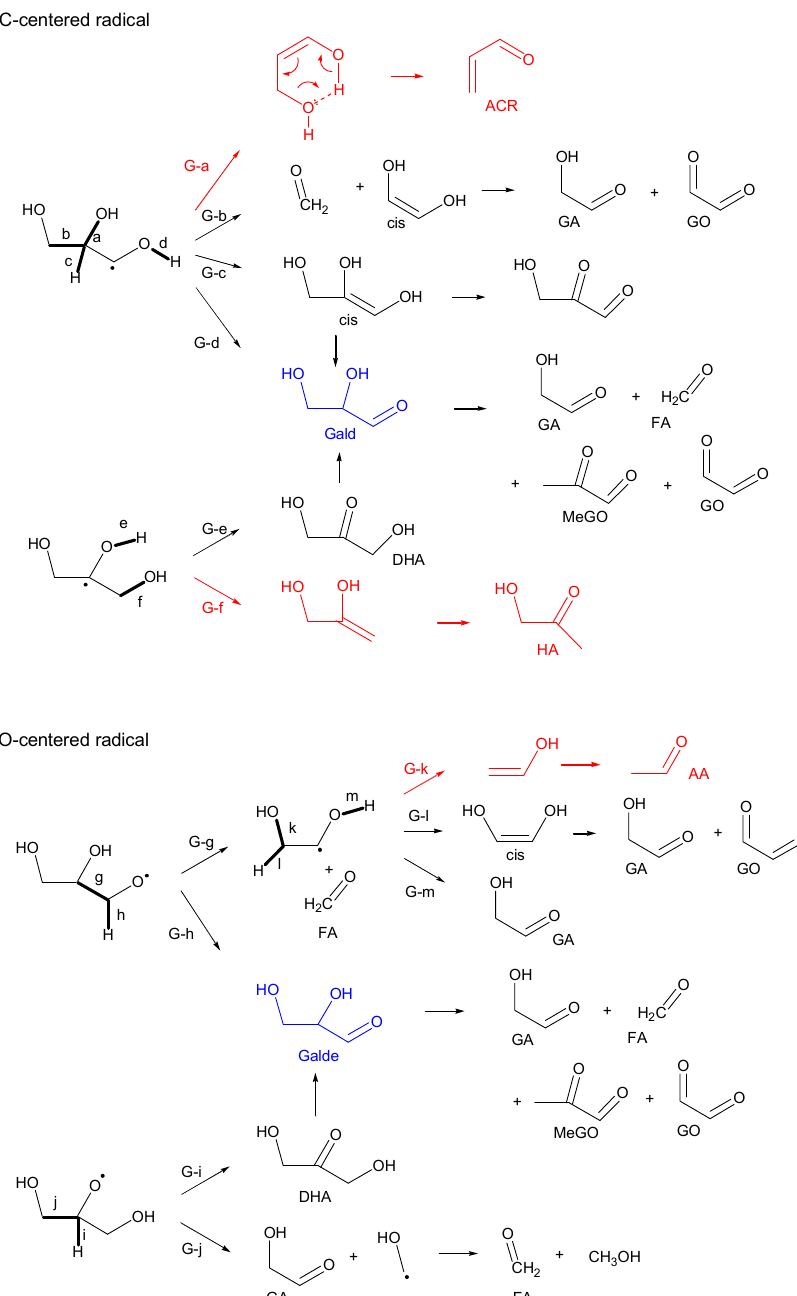
Figure 15. Possible radical chain pathways from the C- and O-centered radicals of glycerol (Gly). The bond with a bold line, which is located at the β -position to the radical, is expected to be cleaved through β -scission reaction. ACR, acrolein; MeGO, methylglyoxal; Gald, glyceraldehyde; DHA, 1,3-dihydroxyacetone; HA, hydroxyacetone; GA, glycolaldehyde; GO, glyoxal; AA, acetaldehyde; FA,